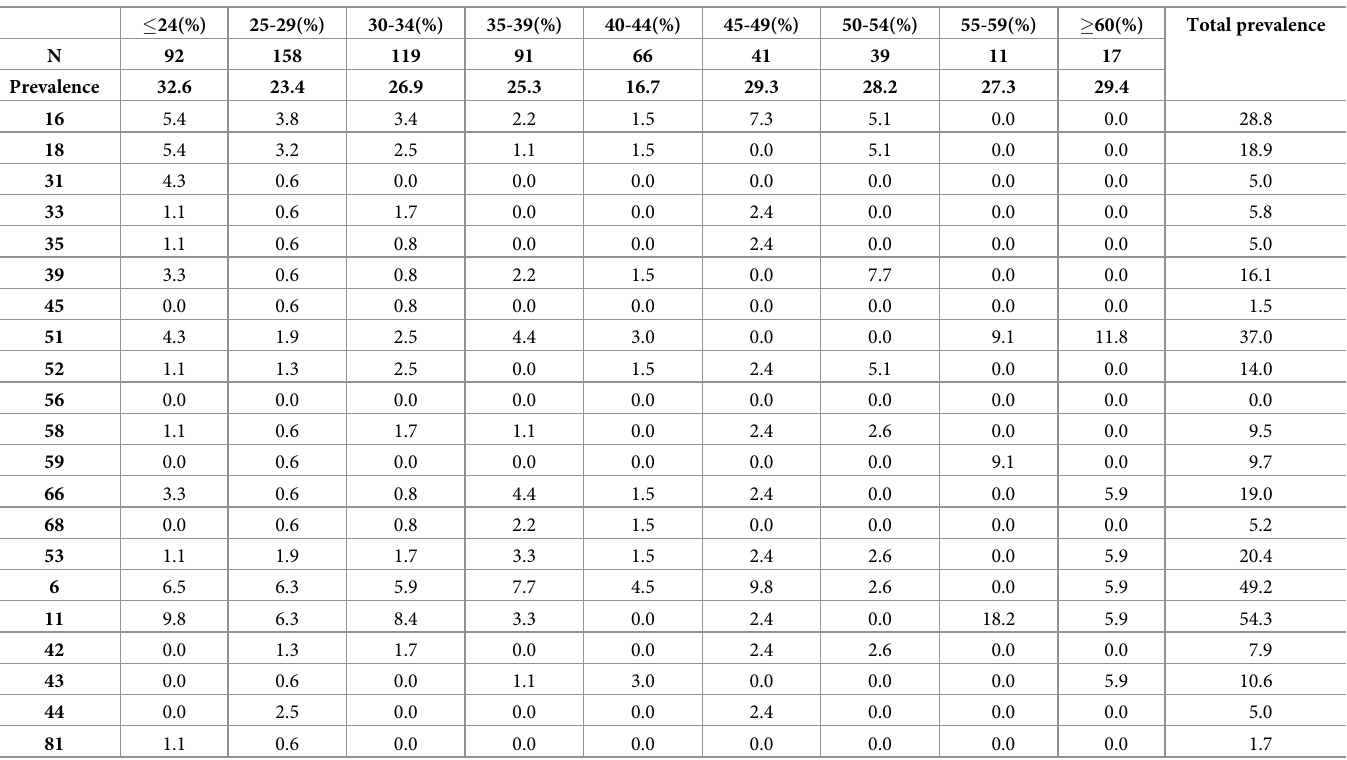
Table 2. Overall age-related HPV prevalence among men.